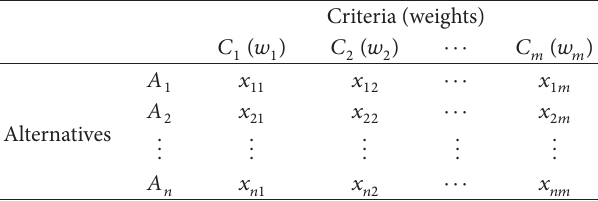
Table 1: Decision matrix.